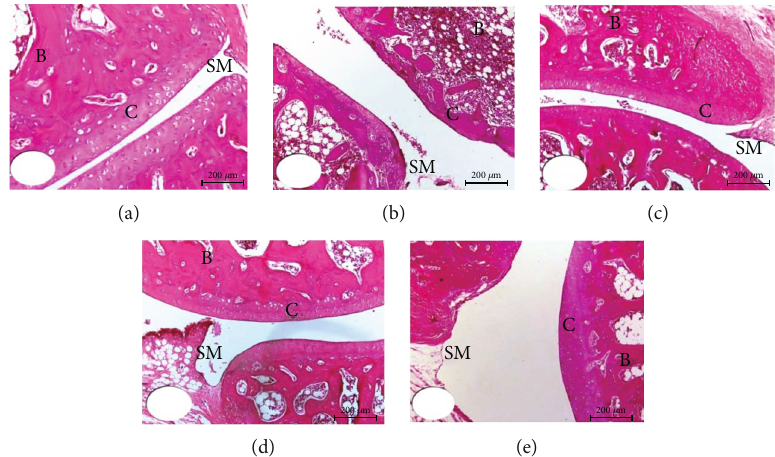
Figure 10: Photomicrographs (200x) of HE-stained sections showing the e ff ect of BM-MSCs and/or IMC treatments on the histopathological changes in the ankle joints of CFA-induced arthritic rats. (a) Normal group. (b) CFA-arthritic control group. (c) CFA+BM-MSC-treated group. (d) CFA+IMC-treated group. (e) CFA+BM-MSC+IMC-treated group. SM: synovial membrane; C: cartilage; B: bone.